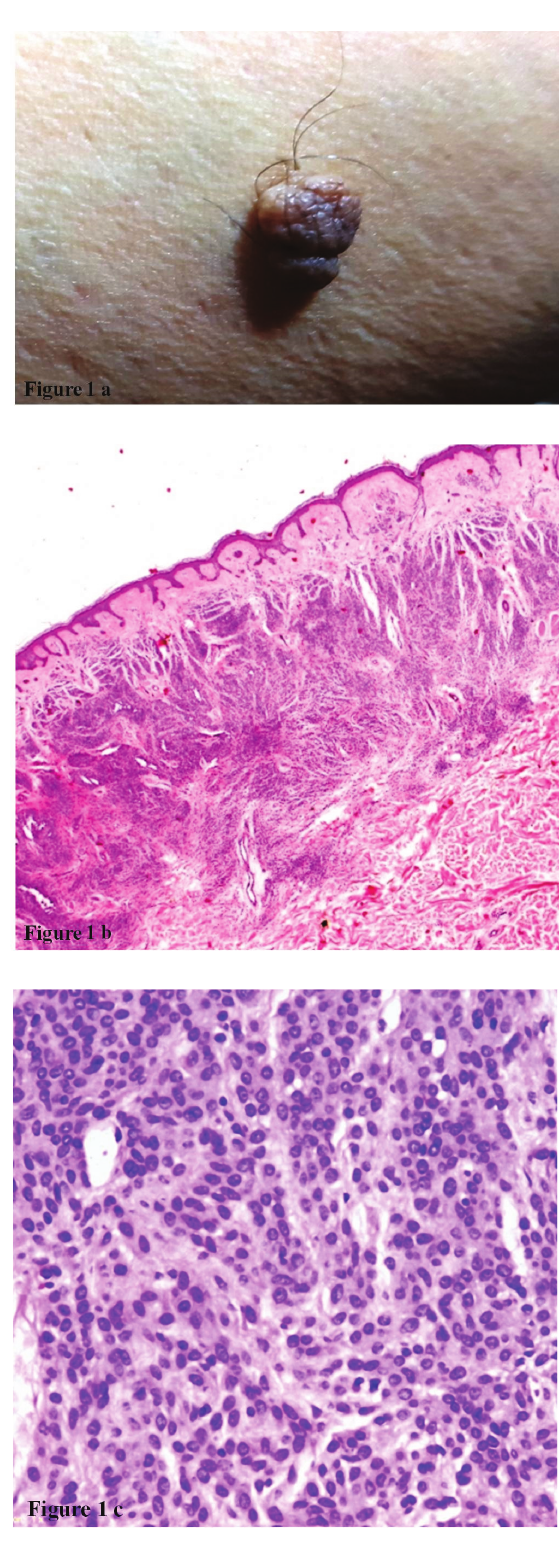
Figure 1: A common acquired melanocytic nevus on the back (Intradermal histologically). Figure 1 b at 20 x: Nevus cells arranged in the dermis. Figure 1 c at 40 x: Benign nevus cells in groups and nests.